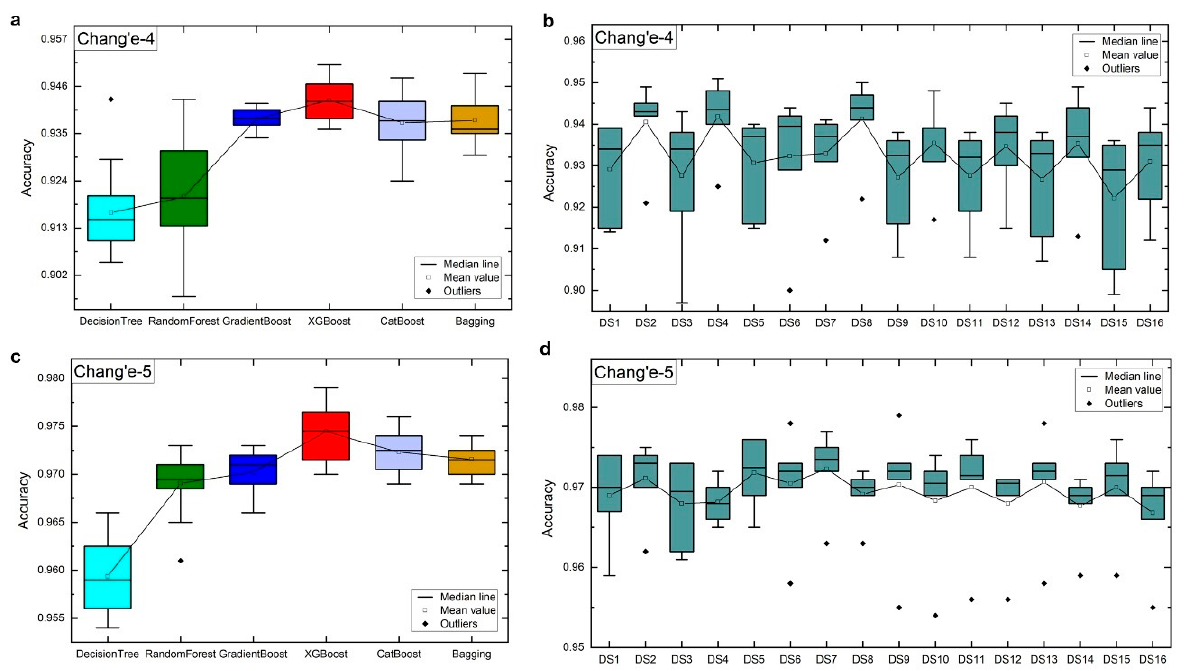
Figure 7. Statistics of the means of the accuracy for 6 machine learning algorithms and 16 datasets. ( a , b ) Chang’e-4 area. ( c , d ) Chang’e-5 area.